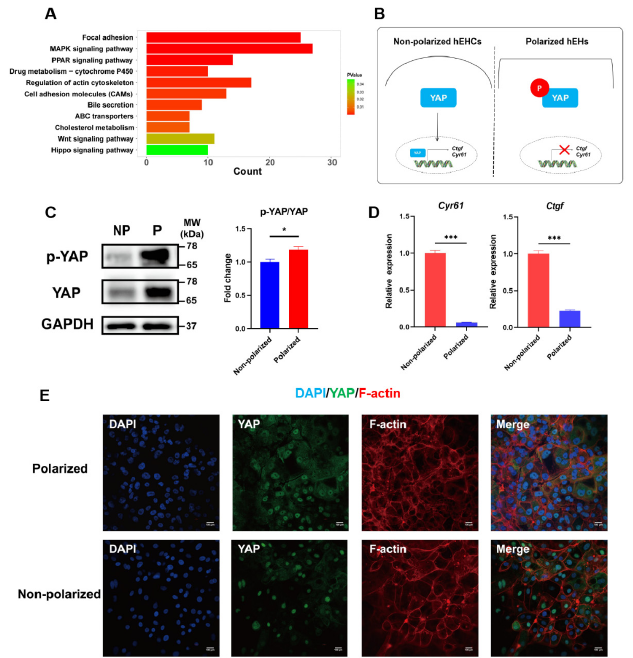
Figure 6. Polarized differentiation activated Hippo signaling pathway in hEHs. ( A ) KEGG pathway enrichment of hEHs between the non − polarized and polarized hEHs. ( B ) Schematic representation depicting the activation of Hippo signaling pathway by the phosphorylation of the YAP in the polarized hEHs. ( C ) Western blot analysis of cell lysates from the non-polarized and polarized hEHs determining YAP phosphorylation level (left panel), quantification of these protein levels normalized to GAPDH protein (right panel). Full − length blots were presented in Supplementary Figure S3. ( D ) Quantitative PCR analysis of YAP downstream genes in the non-polarized and polarized hEHs. Relative gene expression represented data normalized to GADPH and calibrated to the non − polarized hEHs. ( E ) Immunofluorescence analysis of YAP (green) and F − actin (red) in the non − polarized and polarized hEHs; the nuclei were stained with DAPI (blue). Scale bars = 100 µ m. Data represent the mean ± SD. * p < 0.05, ** p < 0.01, *** p < 0.001; n.s. means no